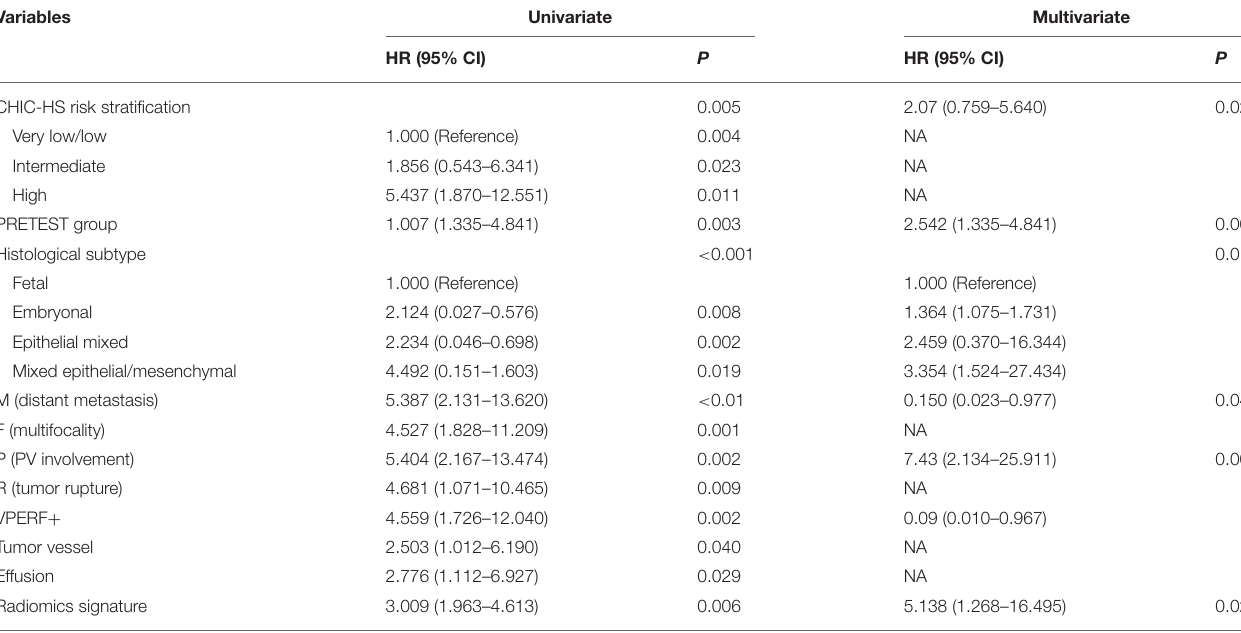
TABLE 2 | Univariate and multivariate analysis of event-free survival for patients in training cohort.